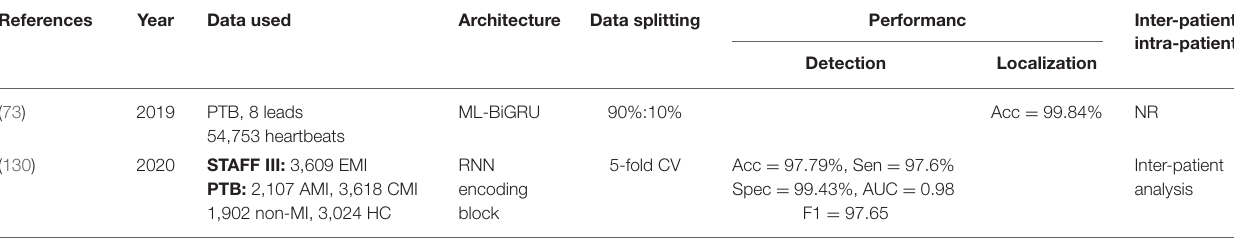
TABLE 9 | Properties of some notable GRU-based ECG MI detection and localization method.